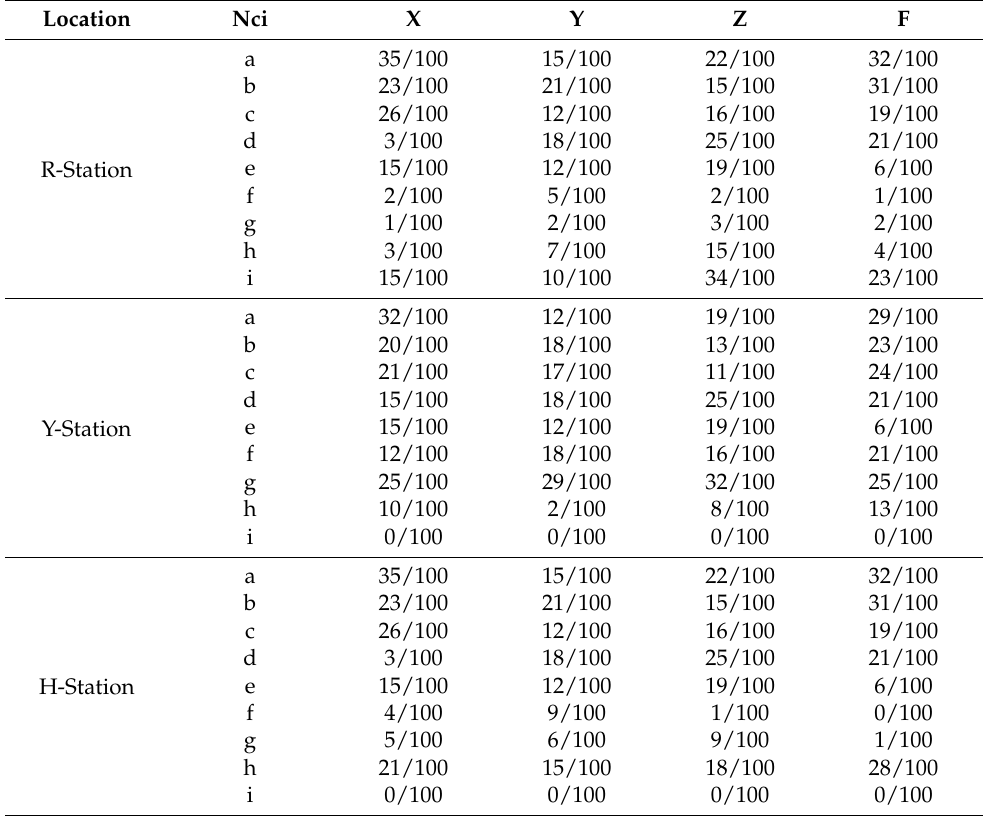
Table 3. Calculation sheet for coordination rate of each